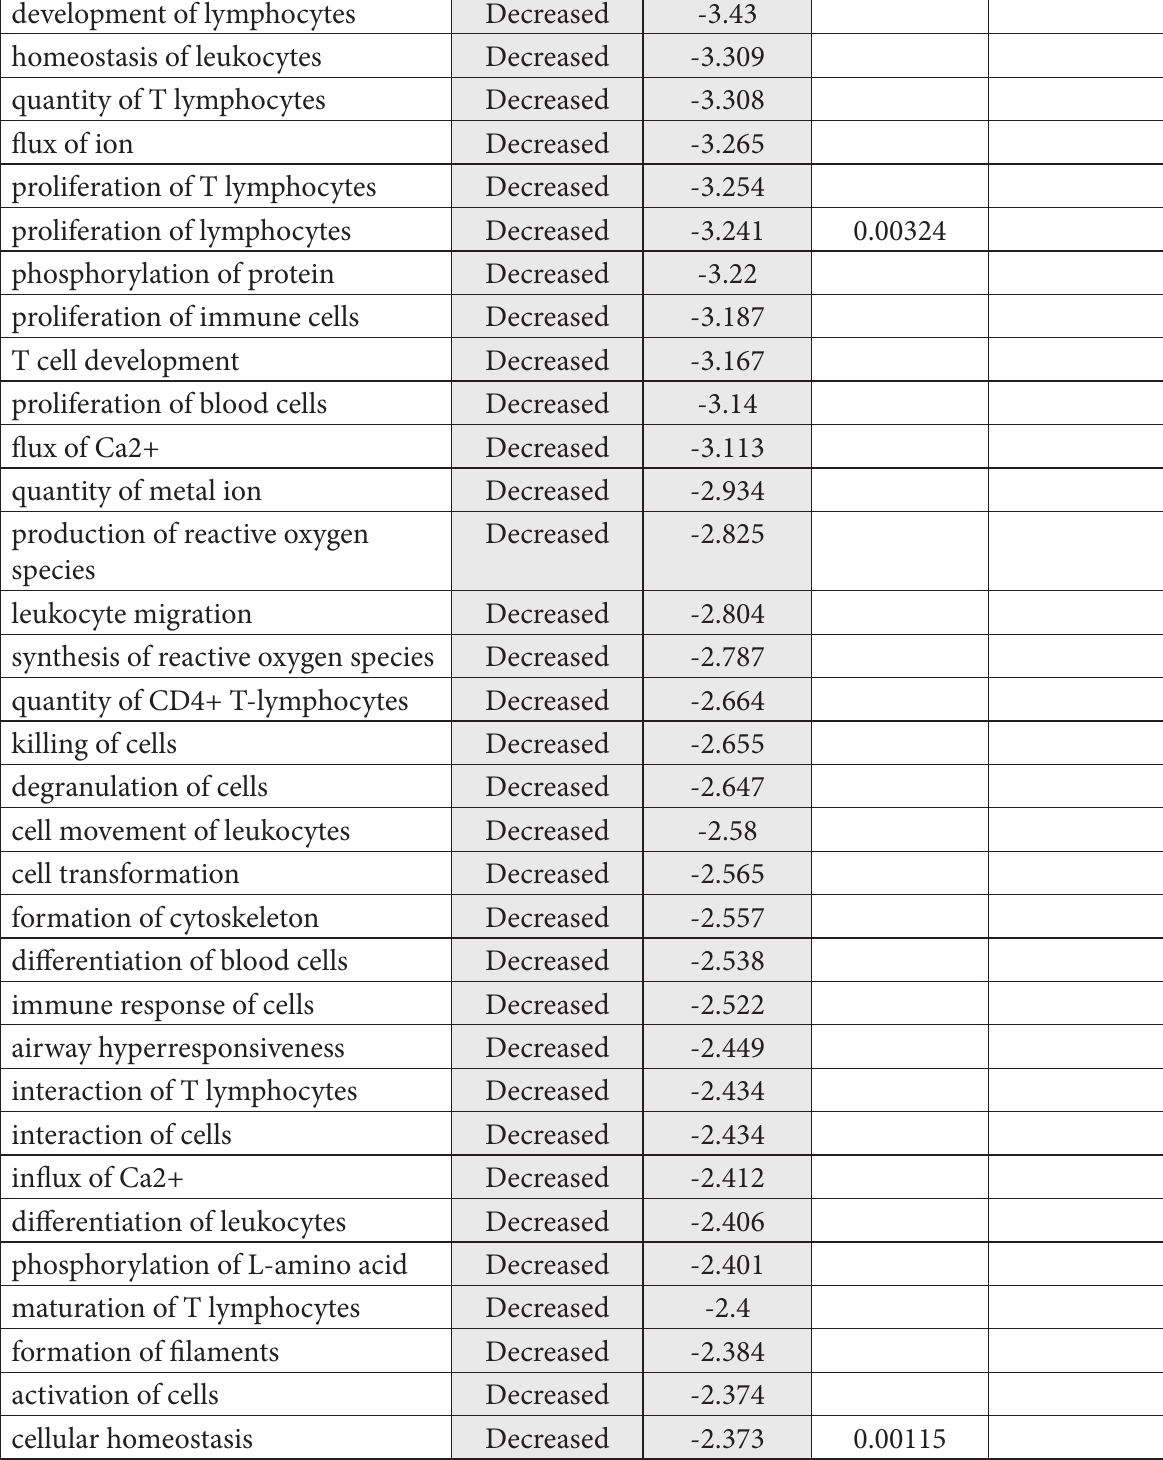
Table 7. Effect of atorvastatin on gene pathways that were significantly altered in HIV/ART compared to HIV-negative individuals at baseline